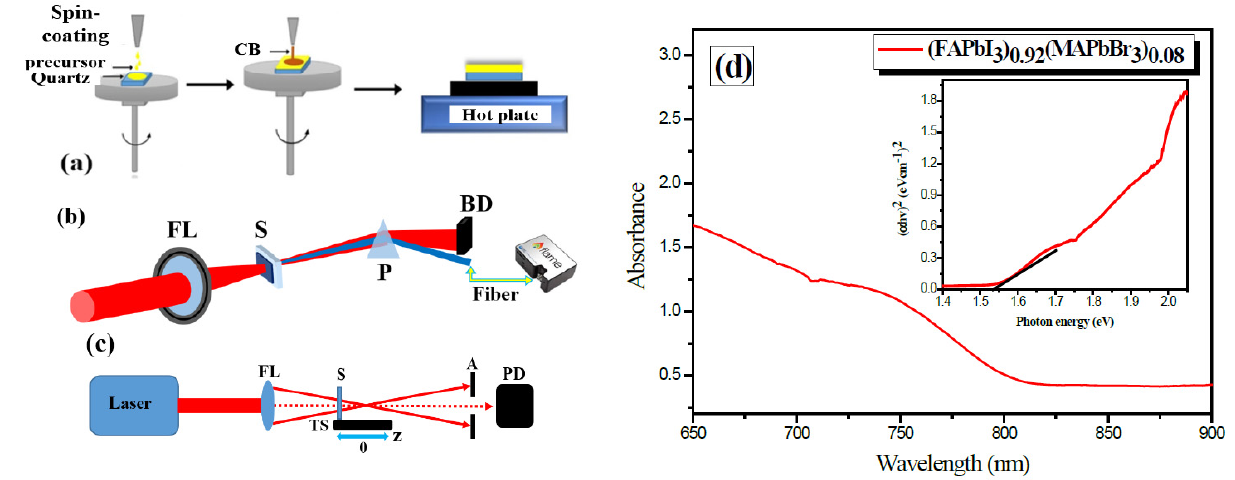
Figure 1. ( a ) Schematic diagram of the deposition steps for the perovskite NCs thin film on the surface of quartz substrate. ( b ) Experimental setup: focusing lens (FL/400 mm), sample (S), calcite prism for dispersion of the main harmonics and their different orders (in particular, the 3rd harmonics), beam dump for dumping main harmonics, silver-coated mirror to direct the 3rd harmonic to the fiber spectrometer. ( c ) Experimental scheme for Z-scan measurements. LASER, femtosecond fiber laser; FL, focusing lens; S, sample; TS, translating stage; A, aperture; PD, photodiode. ( d ) Absorption spectra of the thin film containing mixed perovskite NCs. Inset: the Tauc-plotted absorption spectra of the sample.